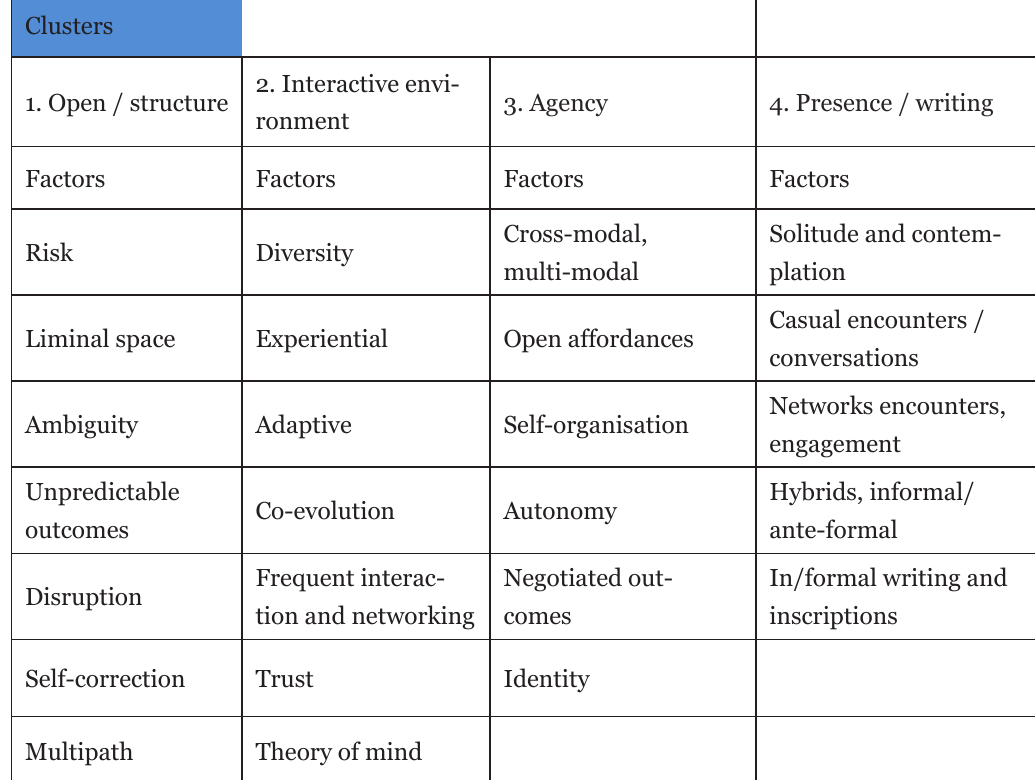
Table 1 Clusters and Factors